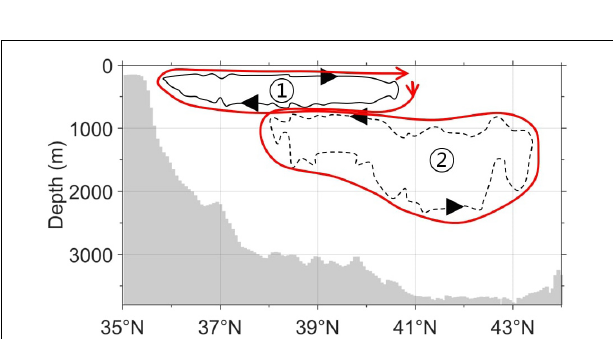
FIGURE 4 | Streamlines of 0.3 Sv ( (cid:192) : solid line) and 0.13 Sv ( (cid:193) : dashed line) for the deep convection case in the meridional overturning stream function from Figure 2B . Individual turnover times are (cid:192) 26.41 years and (cid:193) 37.28 years, respectively.